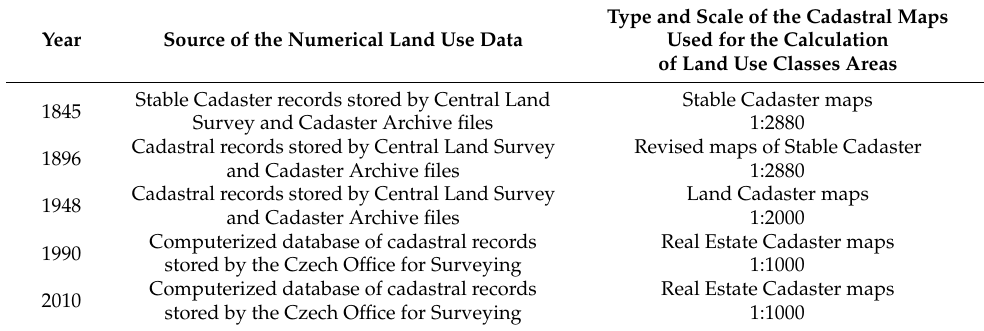
Table 1. Data sources used, type and scale of original cadastral maps for the land use